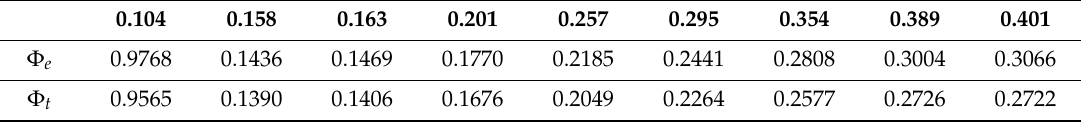
Table 1. Bending moment transmitted by the last plastic hinge, M’ u = δ · M max , for di ff erent steel reinforcement amounts, sections, and concrete grades. The table reports the ratio Φ = δ respectively. The symbol d 1s defined in Section 3, i.e., it denotes the e ff ective depth of the cross-section. The upper row reports the value of ω . The two rows below report Φ e and Φ t